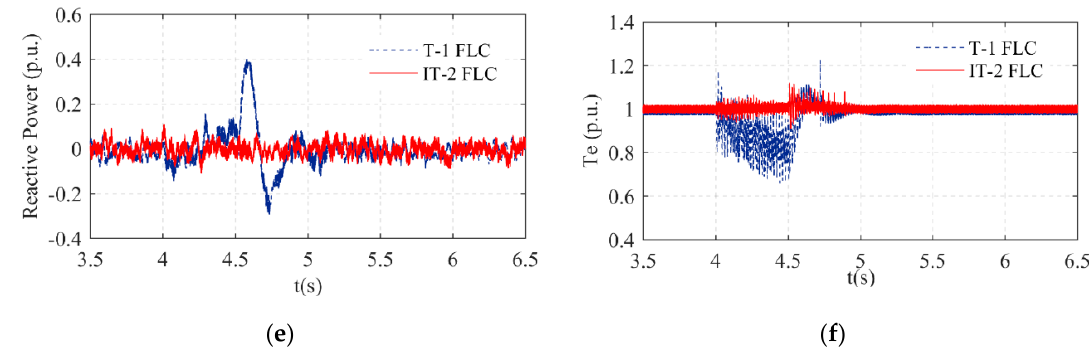
Figure 6 ( a – f ) . Dynamic response of a 1.5 MVA permanent magnet synchronous generator (PMSG) with the type-1 fuzzy logic control (T-1 FLC) and interval type-2 fuzzy logic control (IT-2 FLC) systems during a 2/ ϕ unsymmetrical fault.